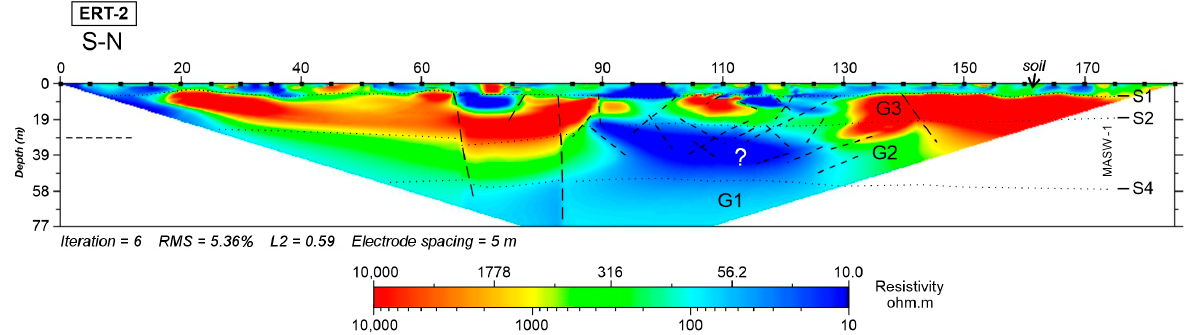
Figure 11. Inverted electrical resistivity tomography data that present a low resistivity anomaly (?) that interrupts the supposed continuity of the resistive gypsum banks.